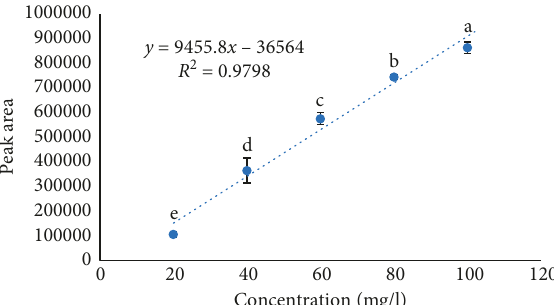
3). a–e: different alphabets indicate a significant difference (cid:30)